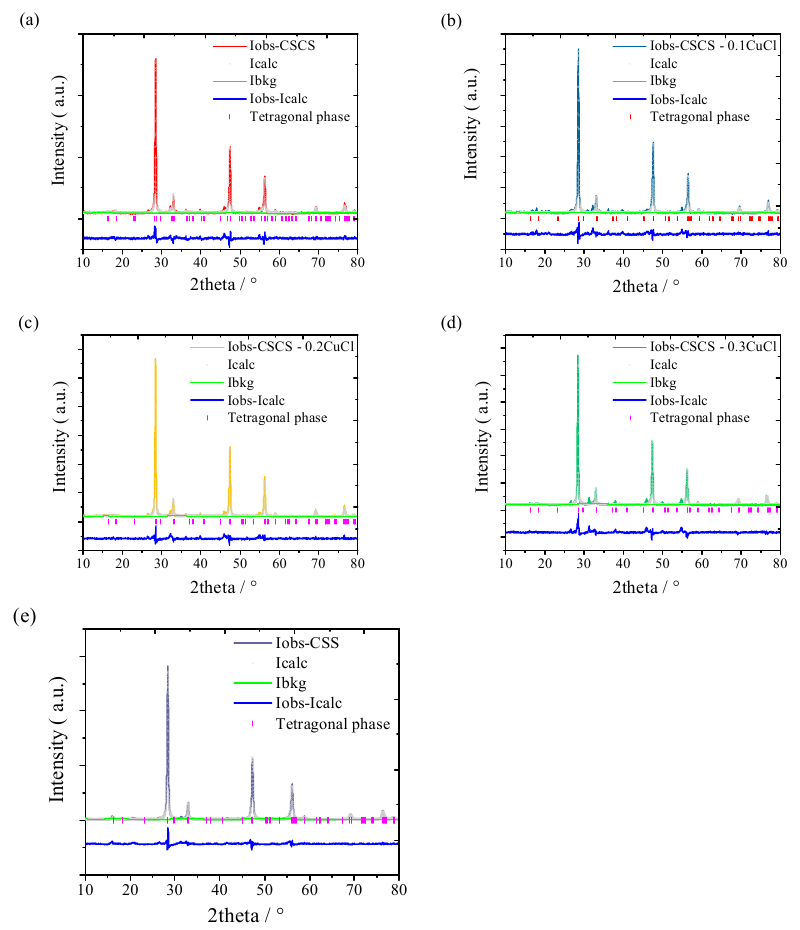
Figure 2. Refinement results for ( a ) CSCS, ( b ) CSCS—0.1CuCl, ( c ) CSCS—0.2CuCl, ( d ) CSCS—0.3CuCl samples and ( e ) pristine sample CSS, respectively. Table 1. The lattice parameters variation against the excess amount of Cu, x , for the CSCS- x CuCl ( x = 0, 0.1, 0.2, 0.3) and CSS samples.